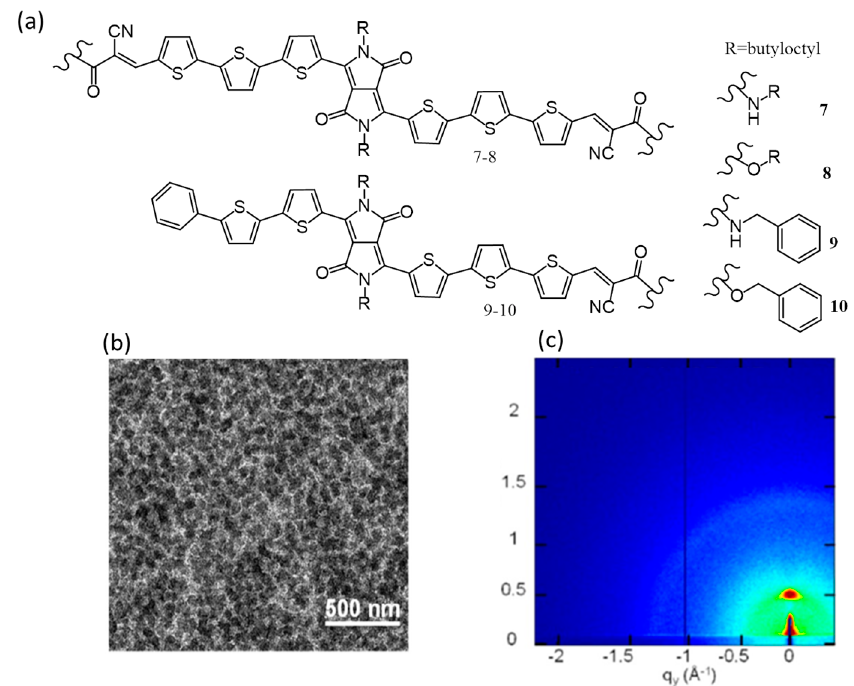
Figure 5. ( a ) Chemical structures of 7 – 10 synthesized by Stupp et al. [52]. ( b ) Transmission electron microscopy (TEM) image of 9 /PC 71 BM and ( c ) two-dimensional grazing incidence X-ray diffraction (2D-GIXRD) of 9 drop-cast from a mixture of CB and NB. Adapted with permission from Ref. [52] Copyright 2015 American Chemical Society.